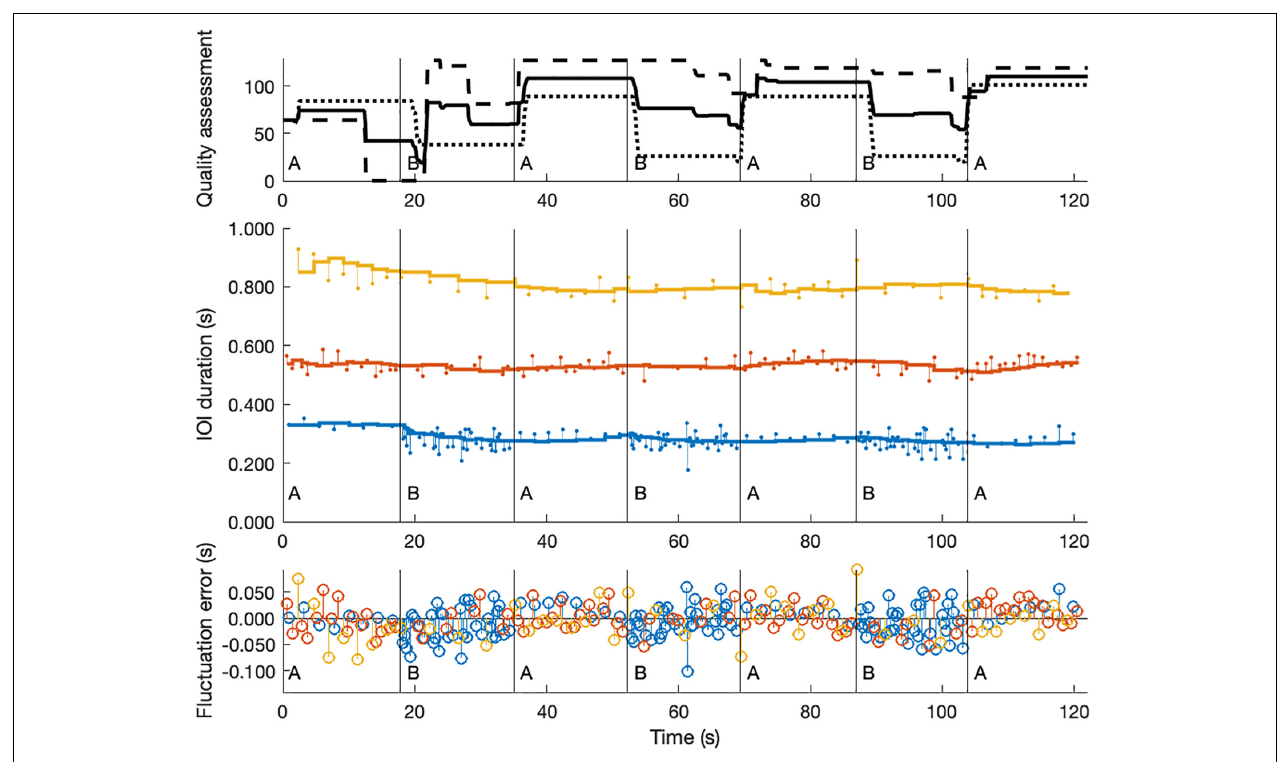
FIGURE 3 | Performance interaction measurements in time-series. In this figure, three time-series of the same performance (a 2-min trial) are visualized. The top plot shows the two quality assessments of the two participants (the dotted lines); the solid line represents the mean of the two assessments. The horizontal lines of the middle plot show how the priors of the three IOI classes evolve over time, according to our Bayesian sequential updating approach. The vertical lines with small dots indicate the deviations of the actual IOI durations with respect to those priors; in other words, they represent the errors in seconds. The plot at the bottom is a summary of the middle plot, where the zero-line represents the priors and the vertical lines are the errors (in seconds) for the three IOI classes (blue = short IOIs; orange = middle IOIs; and yellow = long